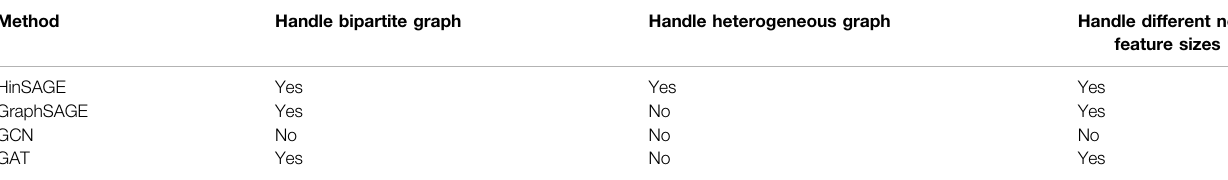
TABLE 1 | Comparison of GNN methods.